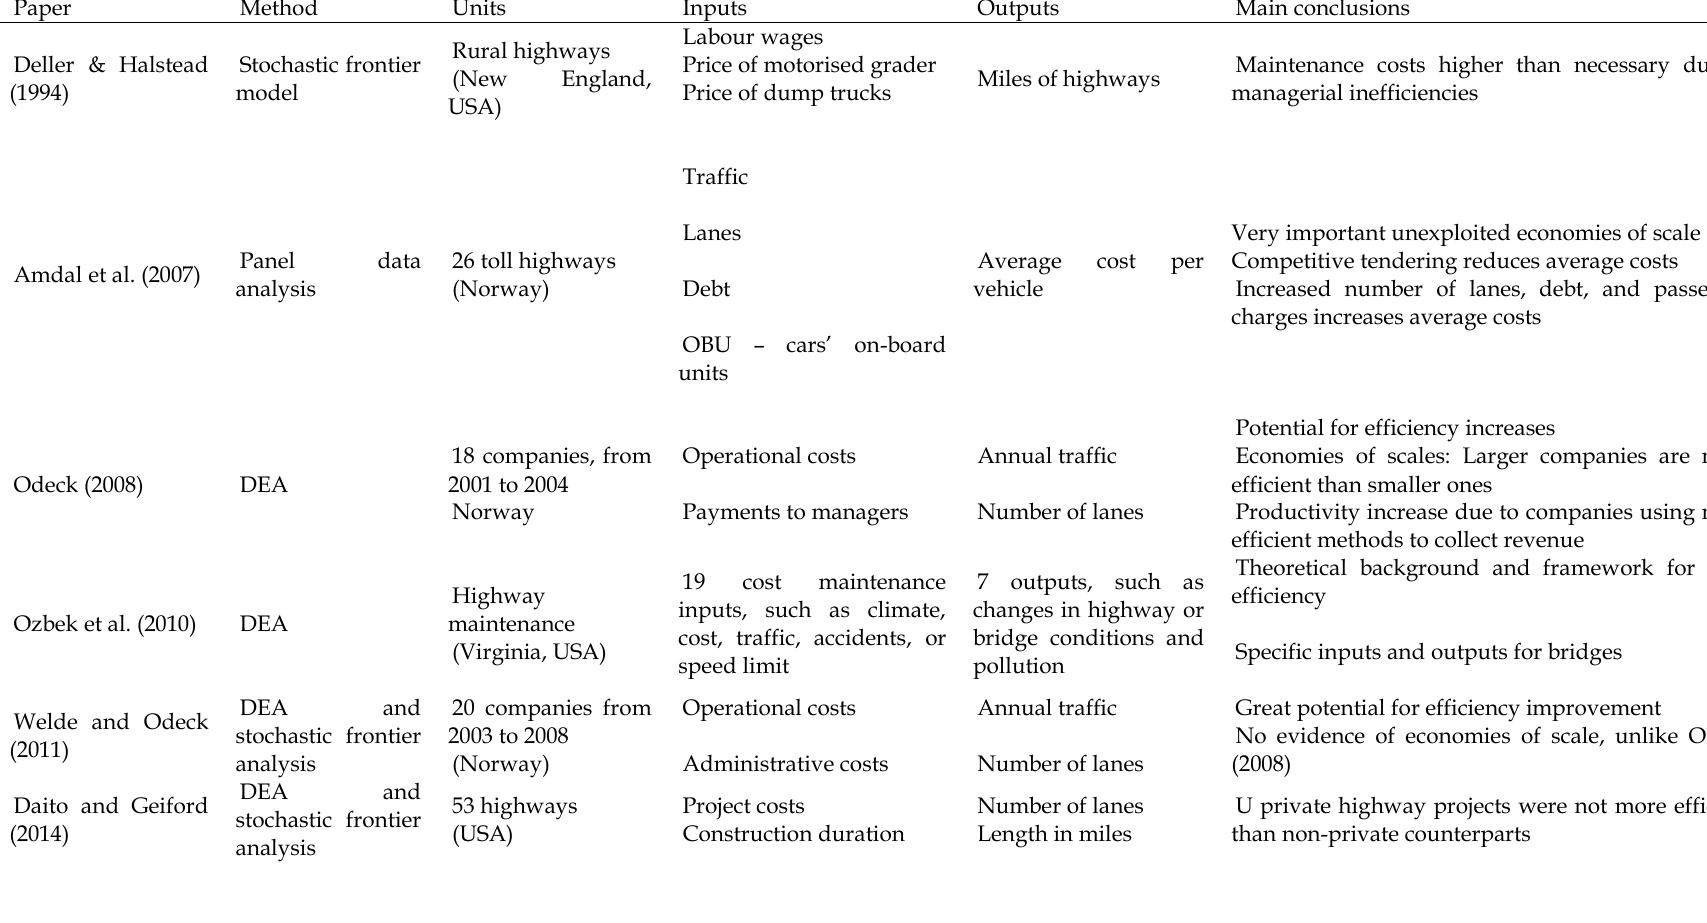
Table 1. Literature review on highway efficiency